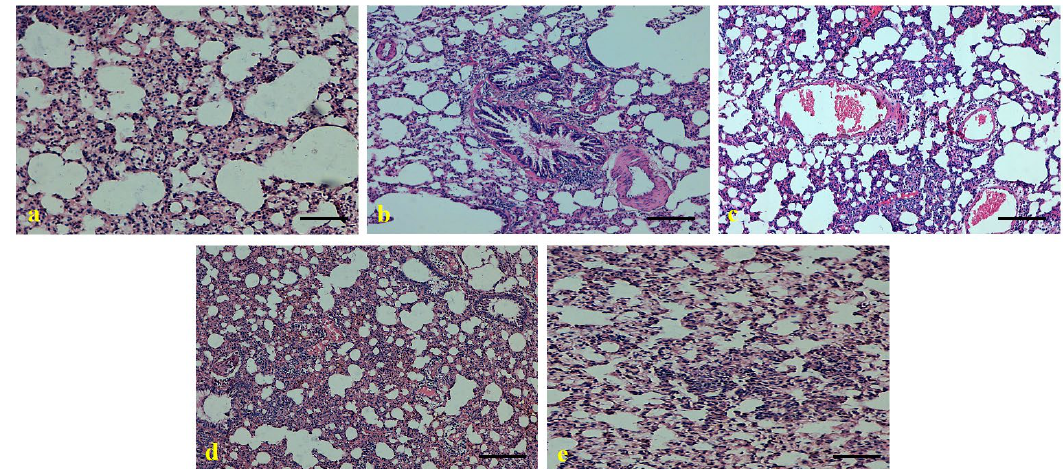
Figure 7. Pathological changes in the lung tissues of different treatment groups of rats. ( a ) Lung architecture in control group rats showed normal architecture, alveolar space, alveolar tissues and normal bronchial ( b , c ) B(a)P-treated group suffered lung damage including interstitial inflammatory cell infiltrate, hemorrhage, congestion, edema, and fibrosis. ( d ) Animals treated with ADE showed remarkable improvement of lung architecture. ( e ) In ADE-treated group only, lung tissue shows typical architecture (Scale bar = 100 µ m).